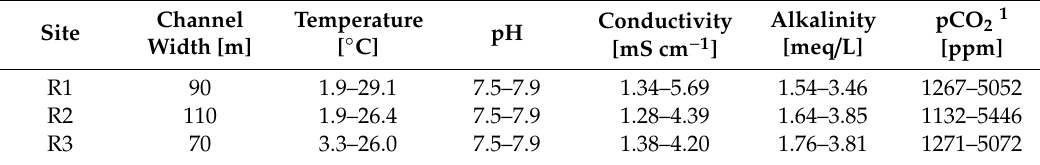
Table 2. Characteristics of riverine CO 2 flux measurement sites.